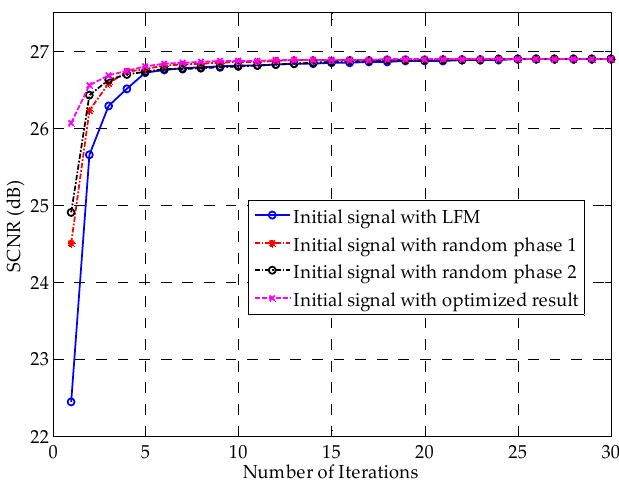
Figure 6. SCNR performances vs. the number of iterations for different initial waveforms.